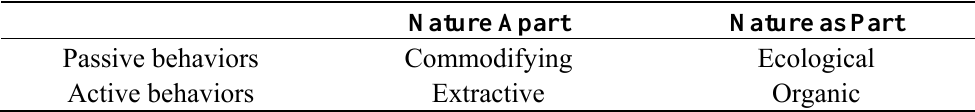
Table 1. Nature interdependence and environmental